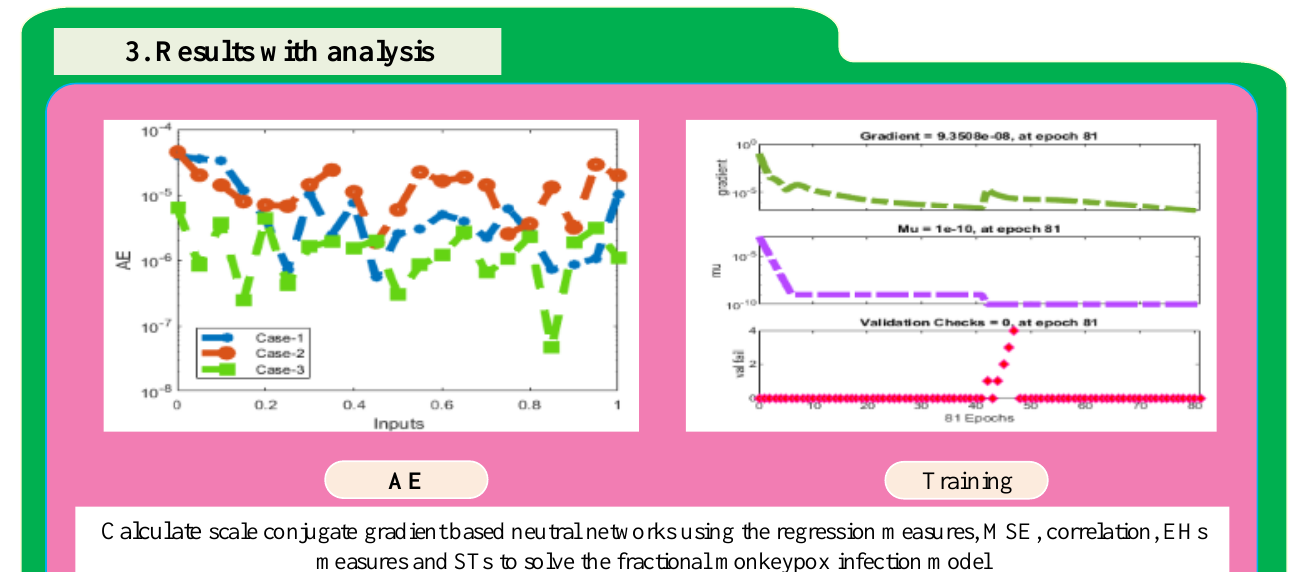
Figure 1. Stochastic illustrations to solve the monkeypox infection system.